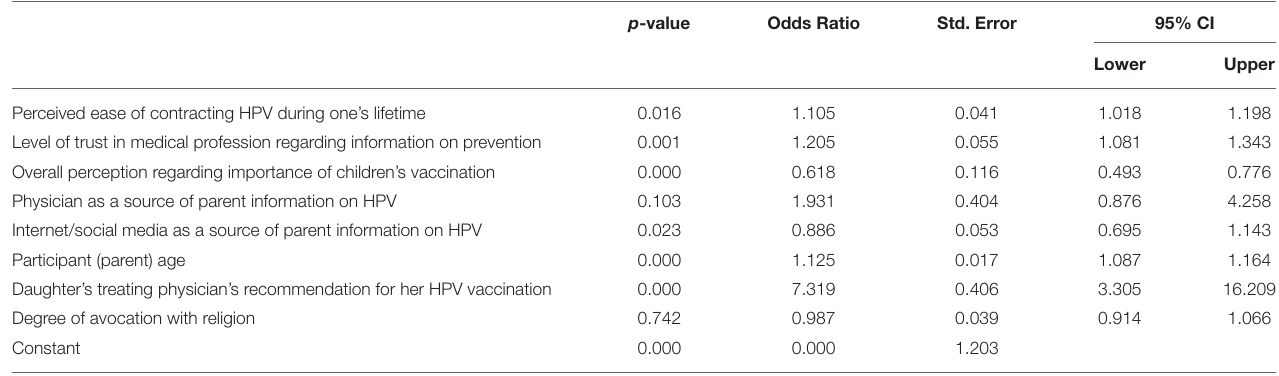
TABLE 5 | Factors associated with (reported) HPV vaccination.